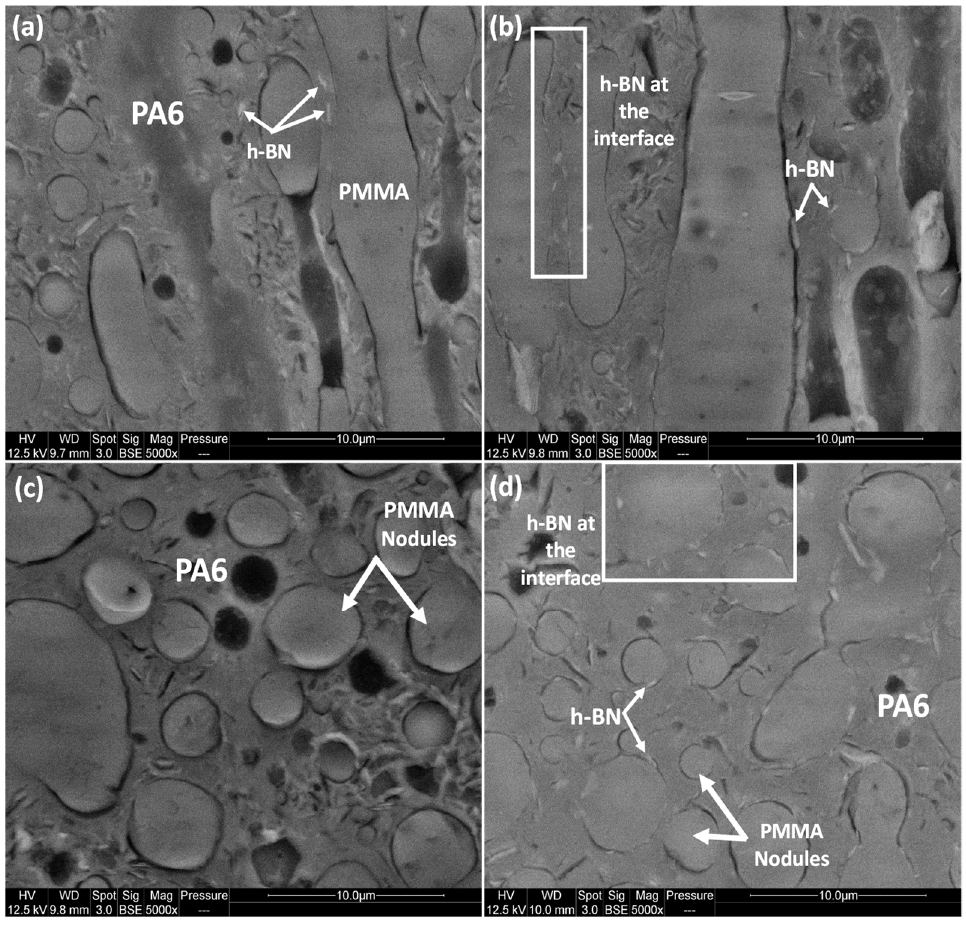
Figure 14. SEM images of (PMMA+h-BN)-PA6 with 8 wt% of h-BN (left column) and (PMMA + BNO Cal/W /Si-PMMA)-PA6 with 8 wt% of BNO Cal/W /Si-PMMA (right column). Parallel cross-polished sections ( a , c ) and perpendicular cryo-fractured surfaces ( b , d